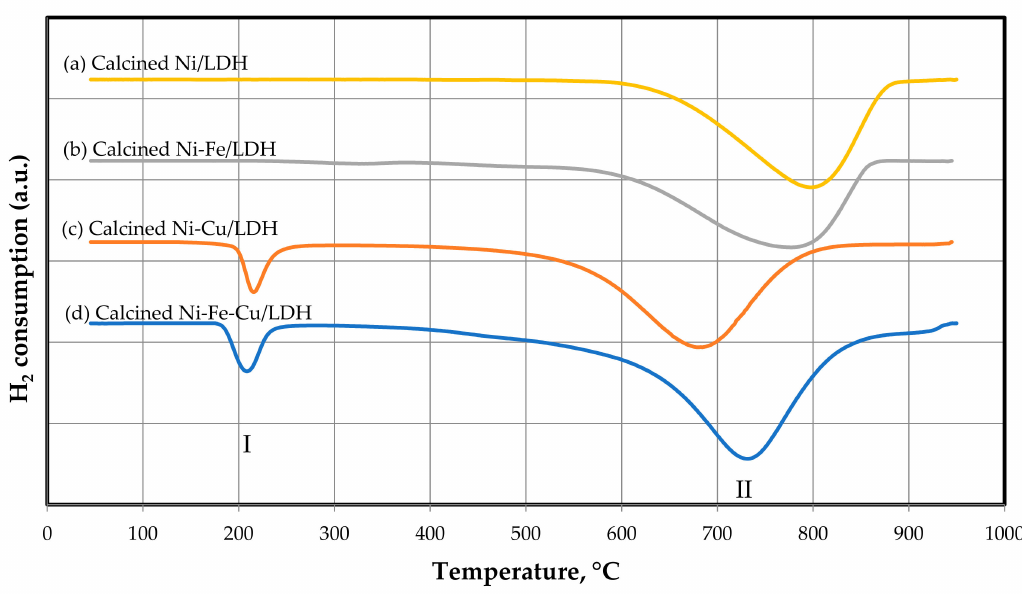
Figure 3. Temperature-programmed reduction (TPR) profile for calcined LDHs.